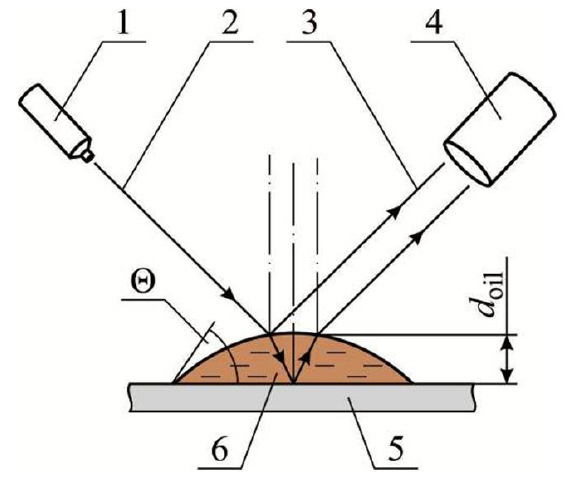
Figure 3. Principal scheme for determining the wetting angle θ and the thickness of the oil layer d oil in an ellipsometric way: 1, 4 — elements of the ellipsometric setup; 2 — linearly polarized light; 3 — elliptically polarized light; 5 — metal surface; 6 — oil layer.